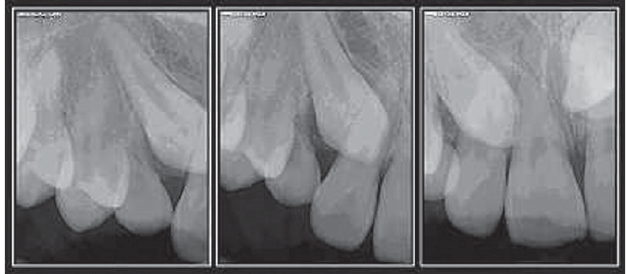
Fig. 2: Clark’s rule to evaluate canine